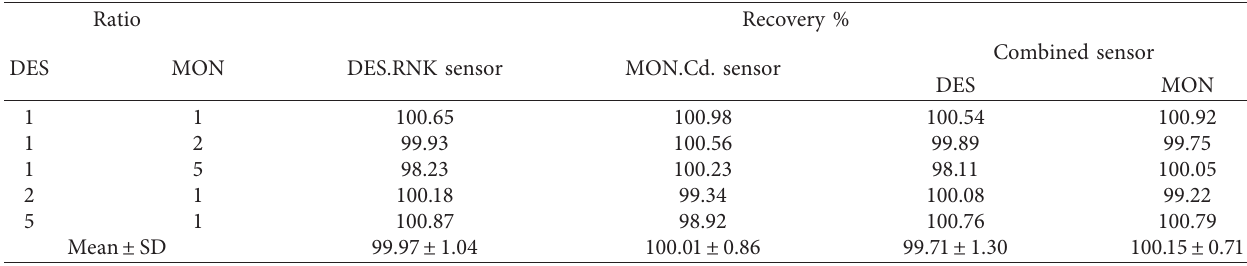
Figure 10: Potentiometric linearity profile of MON.Cd. graphite sensor. Table 4: Determination of DES and MON in laboratory prepared mixtures by the proposed sensors.